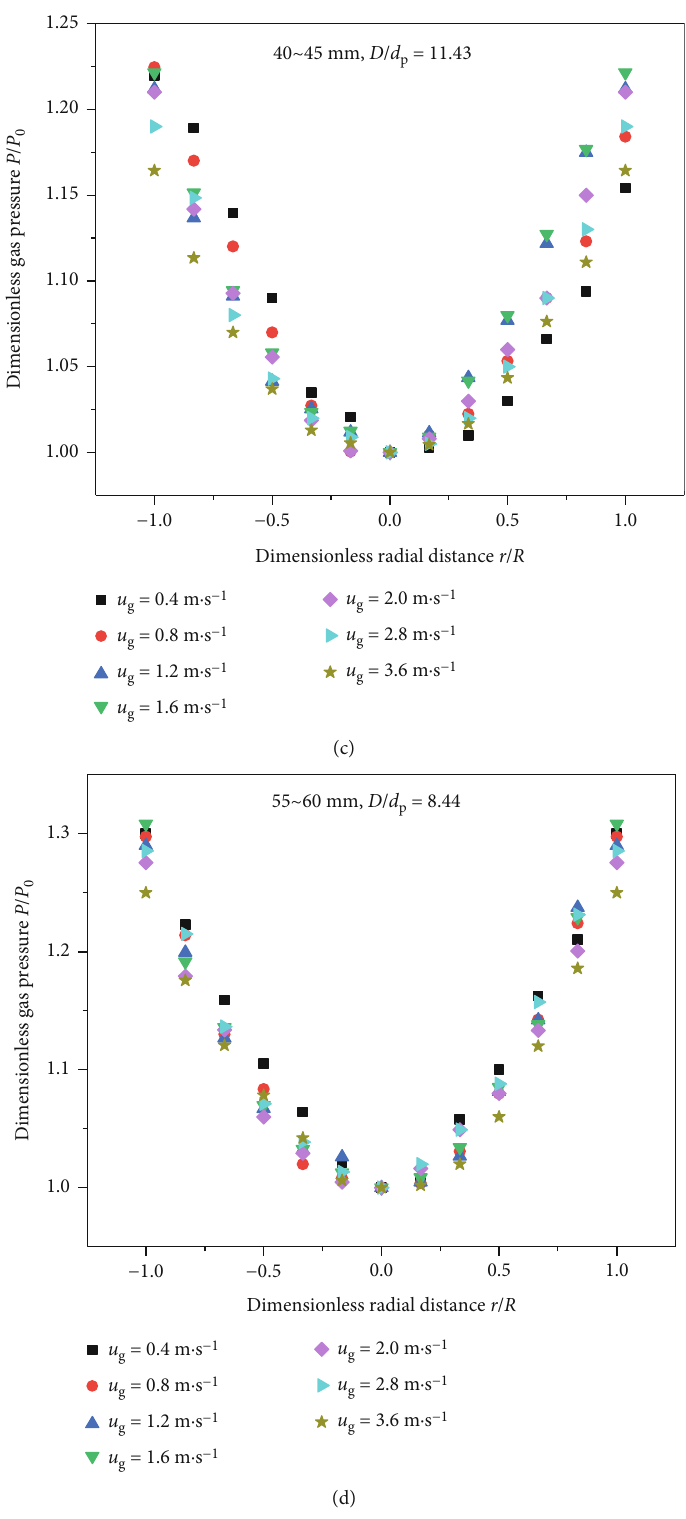
Figure 5: The radial distribution of the dimensionless gas pressure ( P / P (a) 5 ~ 10mm, (b) 20 ~ 25 mm, (c) 40 ~ 45 mm, and (d) 55 ~